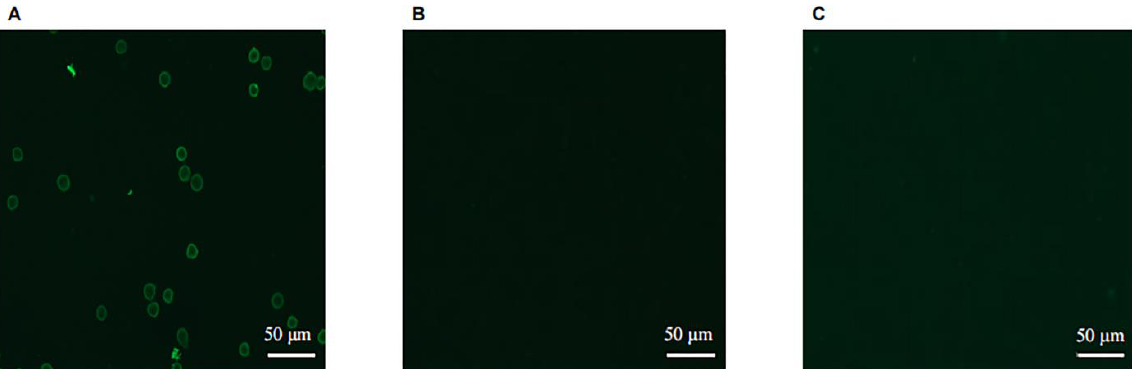
Figure 4. Immunofluorescence analysis of the binding activity of recombinant sdAb to CD20 on the surface of Raji cells. Raji cells were fixed on coverslips, and the recombinant sdAb was used as the primary antibody, and CoraLite ® 488-conjugated 6 × His His-Tag Mouse Monoclonal antibody was used as the secondary antibody at a concentration of 1:150. The samples were placed under a confocal microscope (ZEISS, LSM-800) to detect the fluorescence signal. Bright green fluorescence formed a ring of fluorescence around the cell periphery, as shown in ( A ). However, the control group did not show any fluorescence signal in the absence of the single-domain antibody used for detection, as shown in ( B ) or by fixing the unrelated cell line HEK293A, which did not express CD20 molecule on the surface, and then detected with the single-domain antibody ( C ).